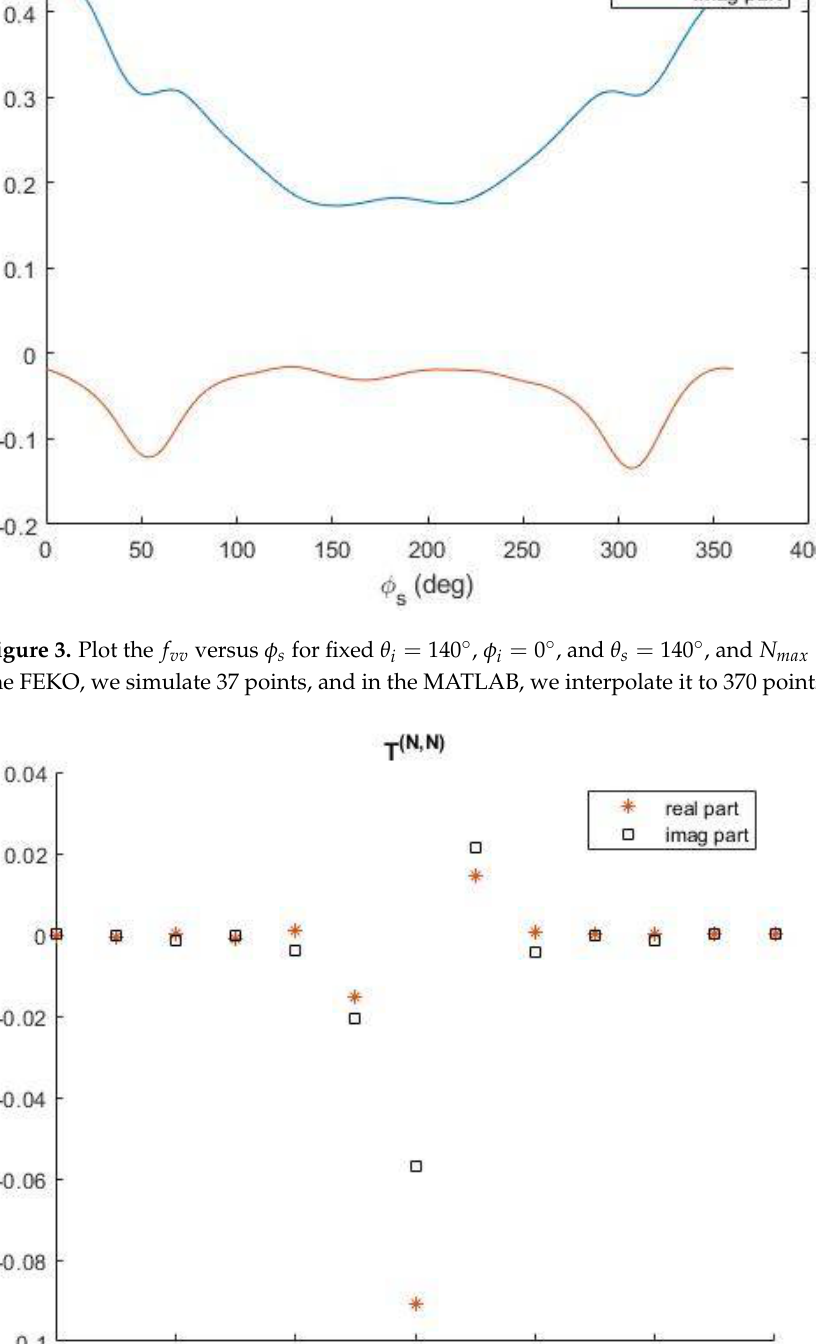
= 140° , (cid:2016) (cid:3036)